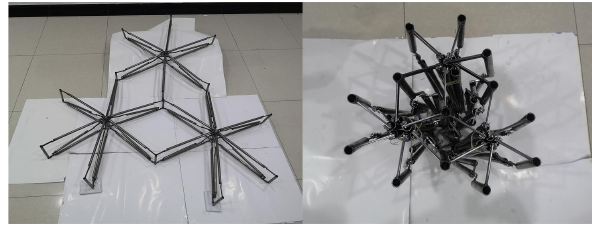
Figure 23. Experimental prototype of deployable mechanism with three